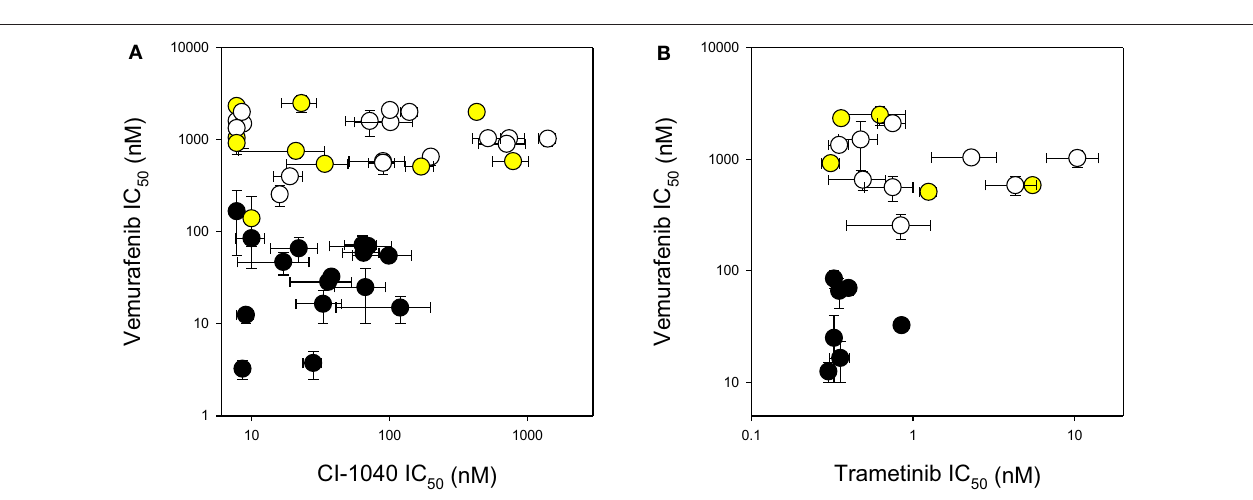
FIGURE 1 | Comparison of IC 50 values for (A) CI-1040 vs. vemurafenib and (B) trametinib vs. vemurafenib using a panel of melanoma cell lines. Black circles: mutant BRAF. Yellow circles: mutant NRAS. White circles: